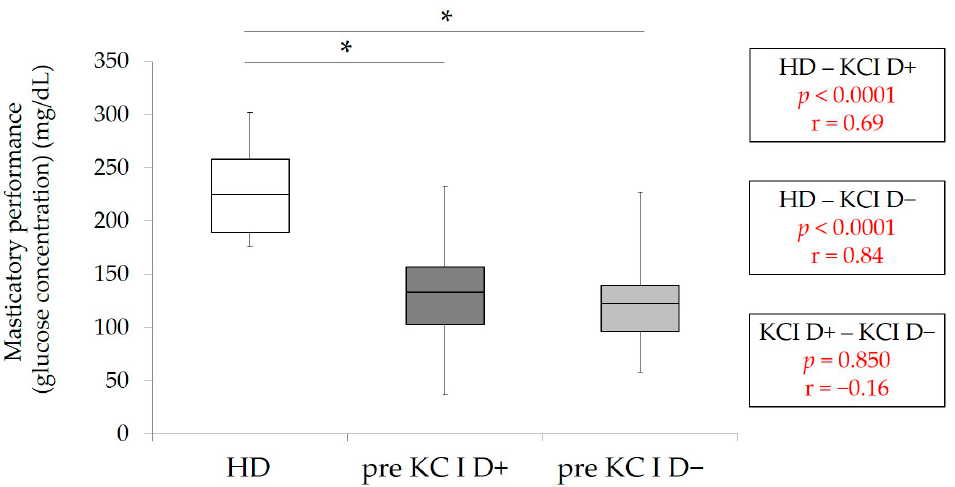
Figure 2. Masticatory function in HD (control group), pre-masticatory function in KC I D+ and D − . * p < 0.001, Kruskal Wallis with multiple comparison, r: effect size. * p < 0.001, Kruskal Wallis with multiple comparison, r: effect size.